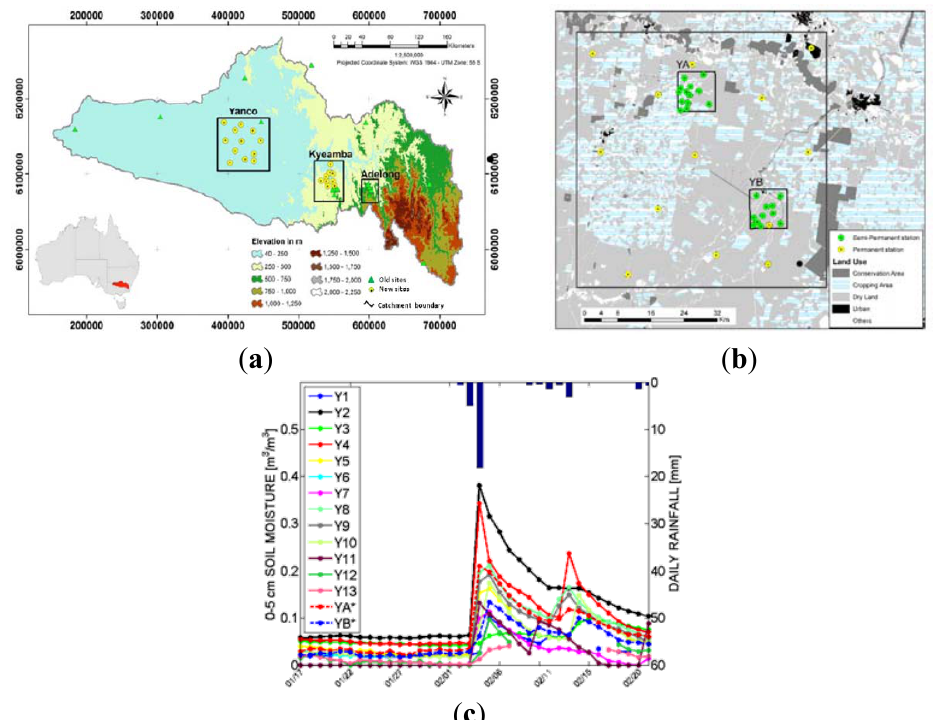
Figure 15. ( a ) Murrumbidgee catchment elevation and permanent soil moisture monitoring network; ( b ) Layout of permanent and semi-permanent SM stations within Yanco intensive monitoring region; ( c ) Surface soil moisture ( s ) and daily rainfall in the different rain m gauges of the network (from [75]).